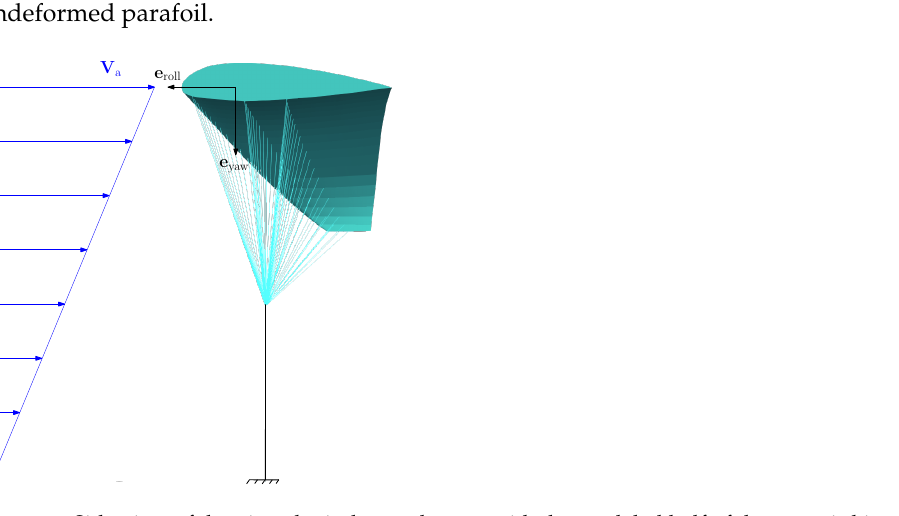
Figure 3. Side view of the virtual wind tunnel setup with the modeled half of the ram-air kite during the power phase assuming steady flight and a negligible influence of gravity (tether length not to scale)